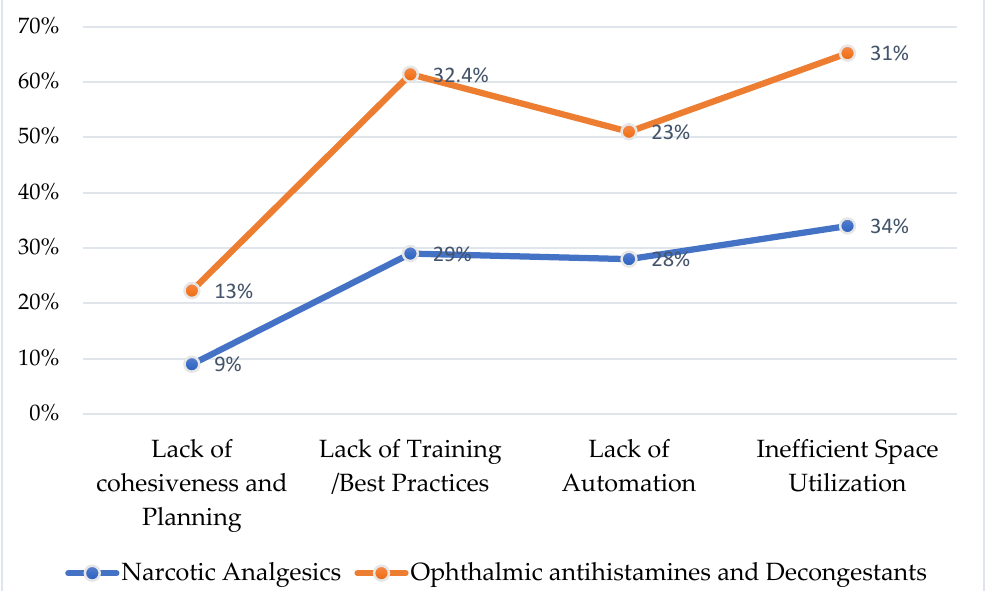
Figure 8. A comparison of the causes of delay in terms of the percentage of cost for ophthalmic antihistamines and decongestants and narcotic analgesics.